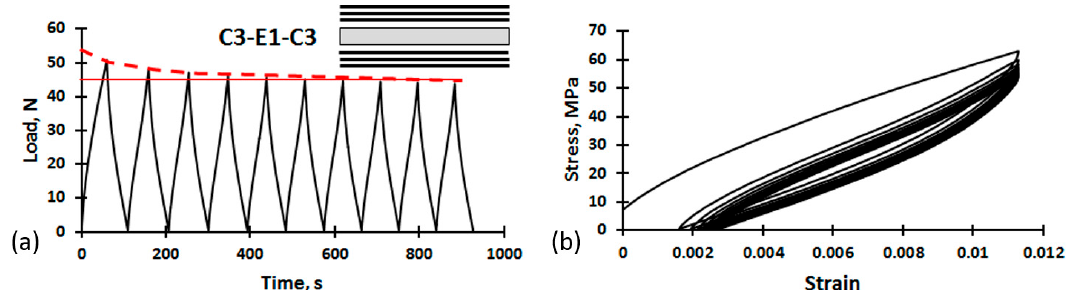
Figure 5. Results from cyclic bending tests in terms of load-time ( a ) and stress–strain curves ( b ). Table 3. Data from DMA and quasi-static bending tests on small samples.